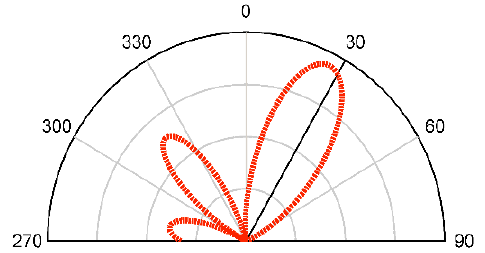
Figure 9. The radiation pattern of the proposed antenna loaded by reconfigurable MM .